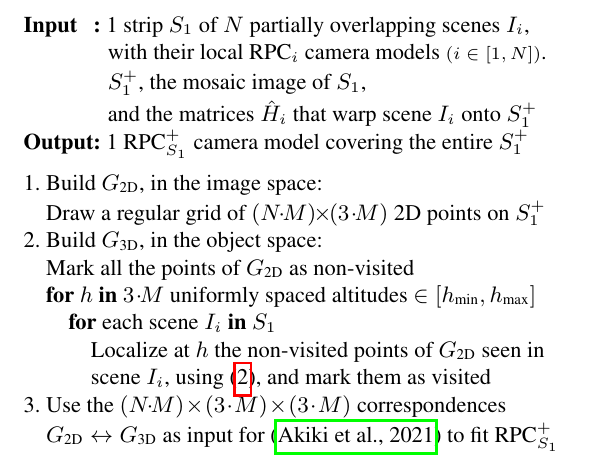
Algorithm 1: Perfect sensor localization model